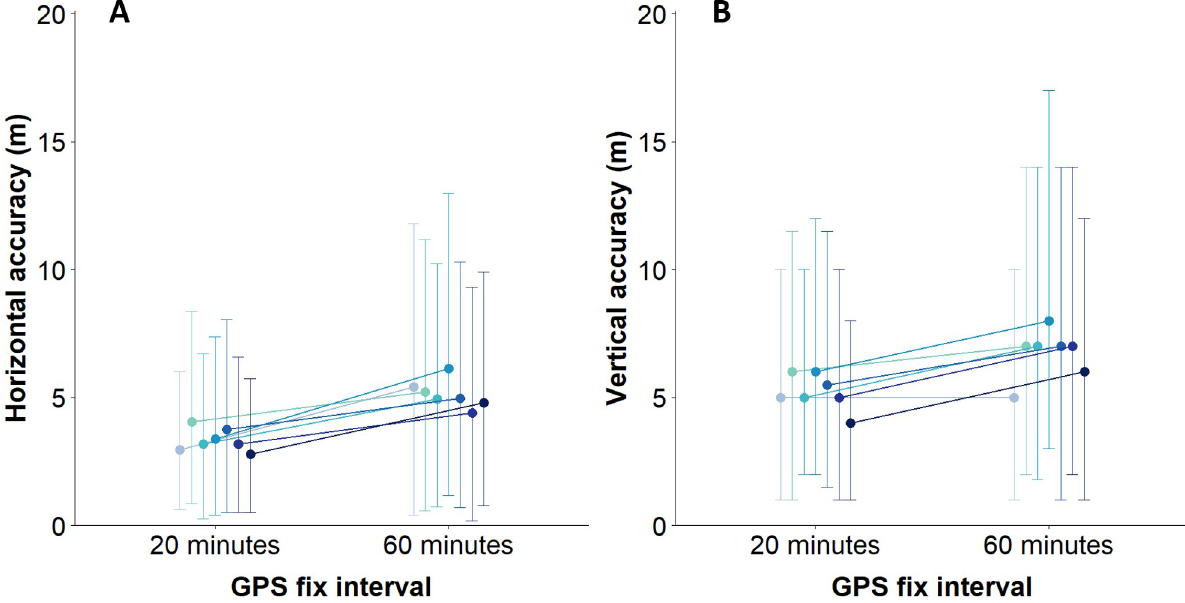
Fig 2. Horizontal and vertical accuracy variability of devices programmed on a 20 and 60 min GPS fix interval. Horizontal (A) and vertical (B) accuracy of tracking devices programmed to collect GPS locations every 20 and 60 minutes. The error bars represent 95% confidence intervals.